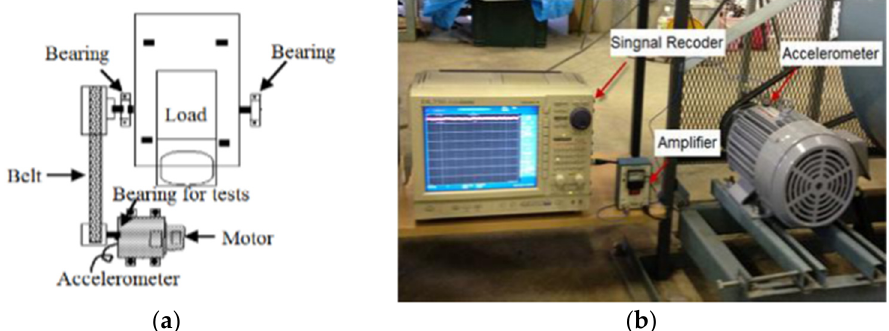
Figure 6. Experiment setup for the rolling bearing fault diagnosis. ( a ) Illustration of the rotation machinery and ( b ) the motor in the field.